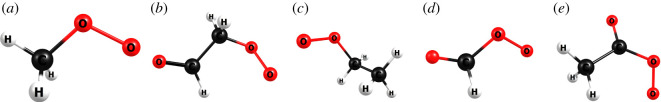
The peroxyl radicals: (a) CH3O2; (b) COHCH2O2; (c) CH3CH2O2; (d) COHO2; and (e) CH3COO2. Colour coding: O, red; C, black; H, white.